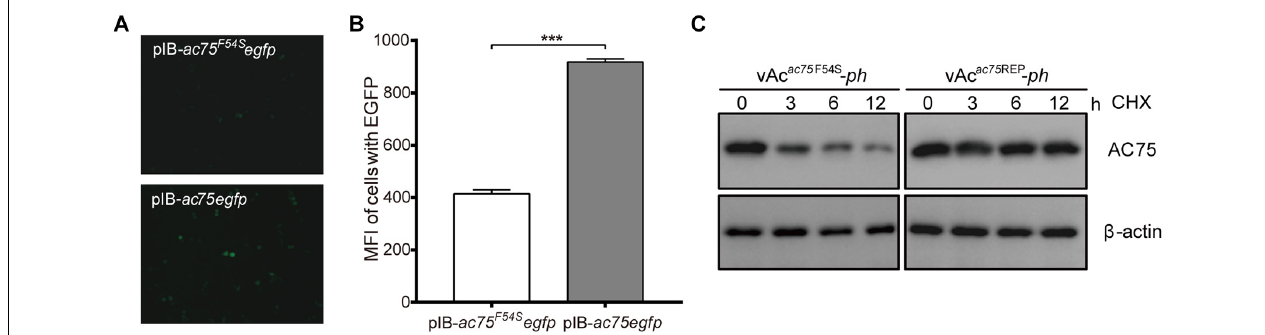
FIGURE 8 | Stability analysis of AC75. (A) Fluorescence analyses. Sf9 cells transfected with pIB- ac75 F 54 S egfp or pIB- ac75egfp plasmids were imaged at 48 h p.t. (B) Flow cytometry analyses. The mean fluorescence intensity of cells expressing the EGFP gene were analyzed by flow cytometry analysis. The values represent averages from three independent assays and error bars represent SD (*** indicates P < 0.001). (C) Western blot analysis. Sf9 cells infected with vAc ac 75 F 54 S - ph or vAc ac 75REP - ph in triplicate at an MOI of 5 were treated with CHX at 24 h p.i. Lysates prepared at the indicated times thereafter were subjected to immunoblot analysis by using anti-AC75 and anti-actin